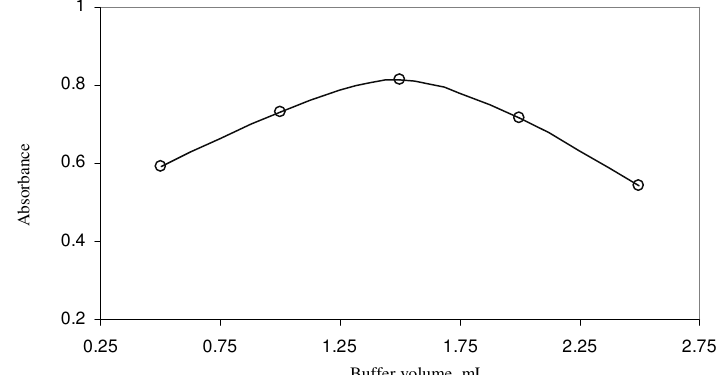
Figure 7. Effect of volume of acetate buffer pH 3.7 on the reaction of bromothymol blue with 800 µ g mL -1